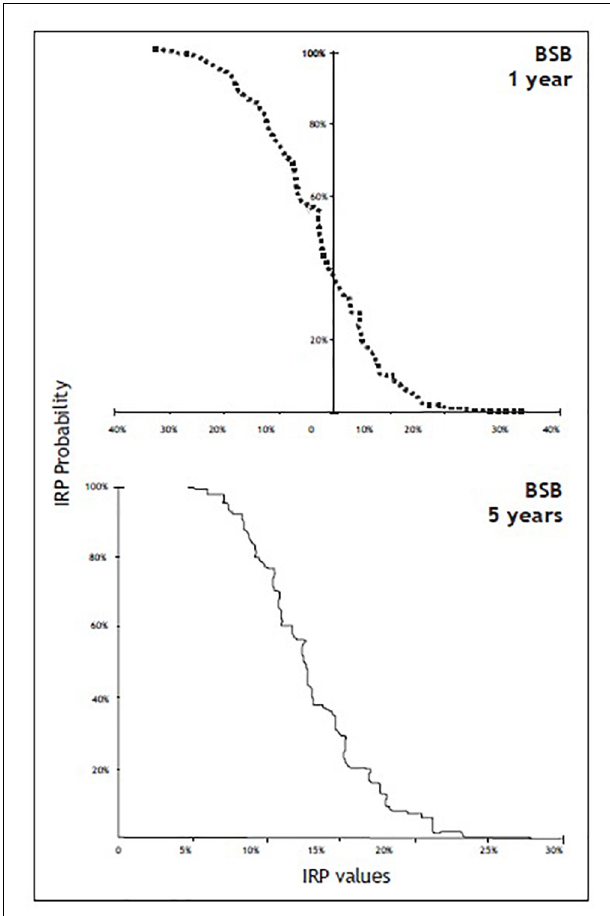
FIGURE 7 | Incremental Profitability Rate ( IRP ) profiles for BSB at 1- and 5-year scenarios.